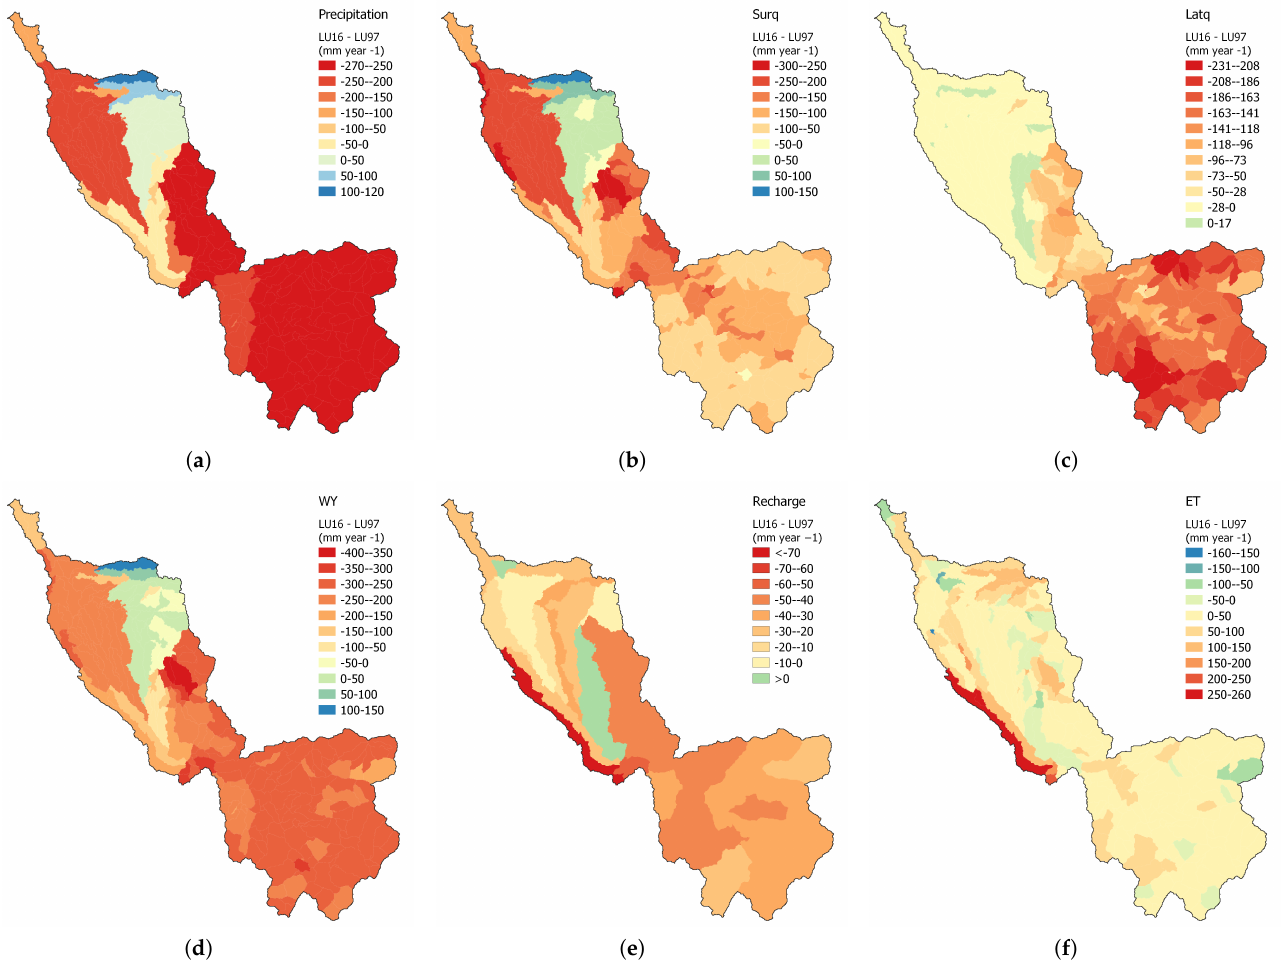
Figure 8. Changes between 1990 and 2019 under LU 1997 and LU 2016 for the parameters: ( a ) Pre- cipitation, ( b ) Surface flow, ( c ) Lateral flow, ( d ) Water yield, ( e ) Recharge and ( f )